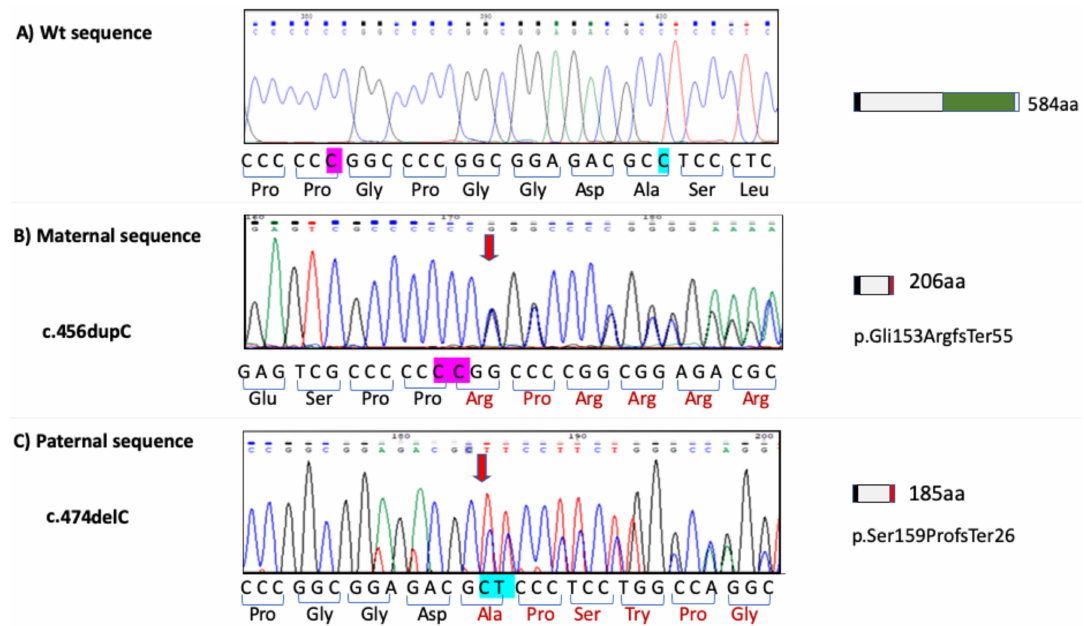
Figure 4. FAM20C gene sequence analysis from Family. ( A ) Electropherogram showing wild-type FAM20C sequence and localization sites of maternal and paternal variants. ( B ) Electropherogram showing identified maternal variant sequence c.456dup corresponding to p.Gly153Argfs*56 and e ff ect on size protein. ( C ) Electropherogram showing paternal variant sequence c.474delC corresponding to p.Ser159Profs*28 and size protein e ff